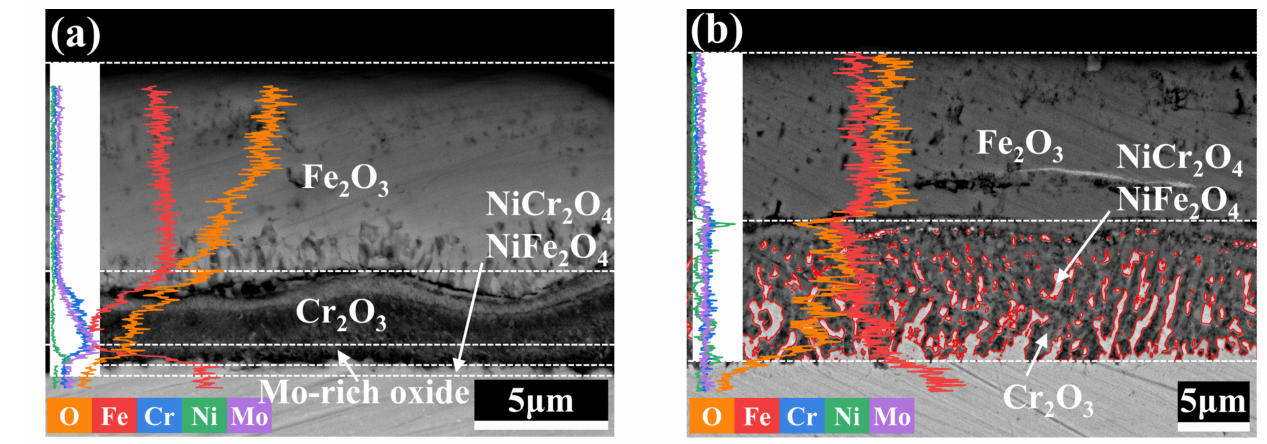
Figure 5. BSE-EDS line profiles of 3Cr3Mo2NiW ( a ) and 3CrNi3Mo ( b ) steel cross-sections.